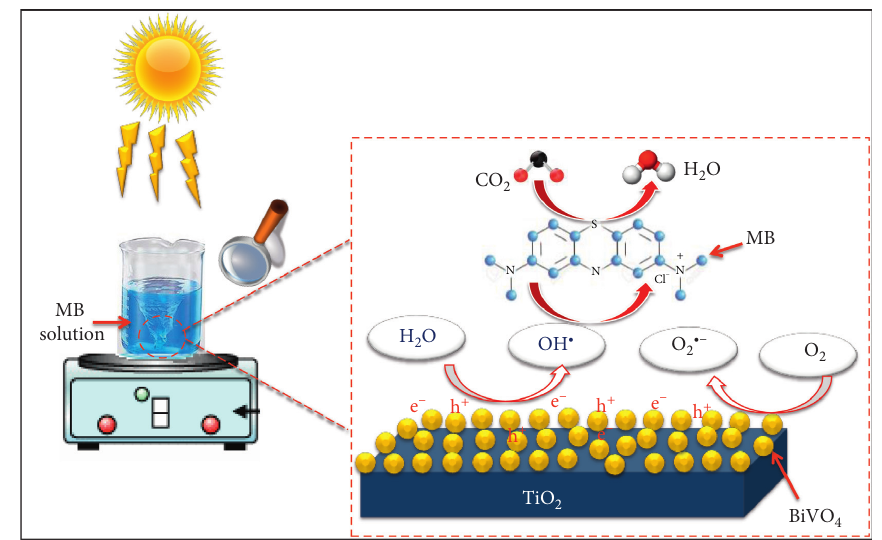
Scheme 1: Schematic illustration of methylene blue